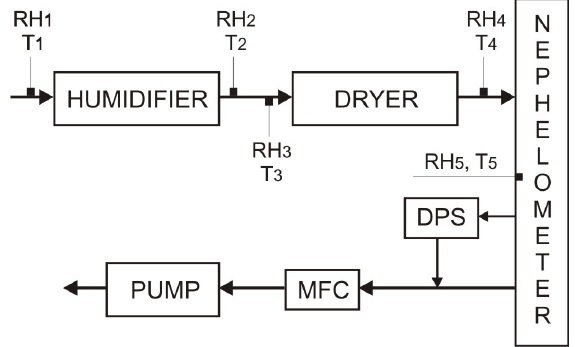
Fig. 1. Set-up of the humidified nephelometer, with five temperature ( T ) and capacitive RH sensors, a dew point sensor (DPS) and a mass flow controller (MFC).